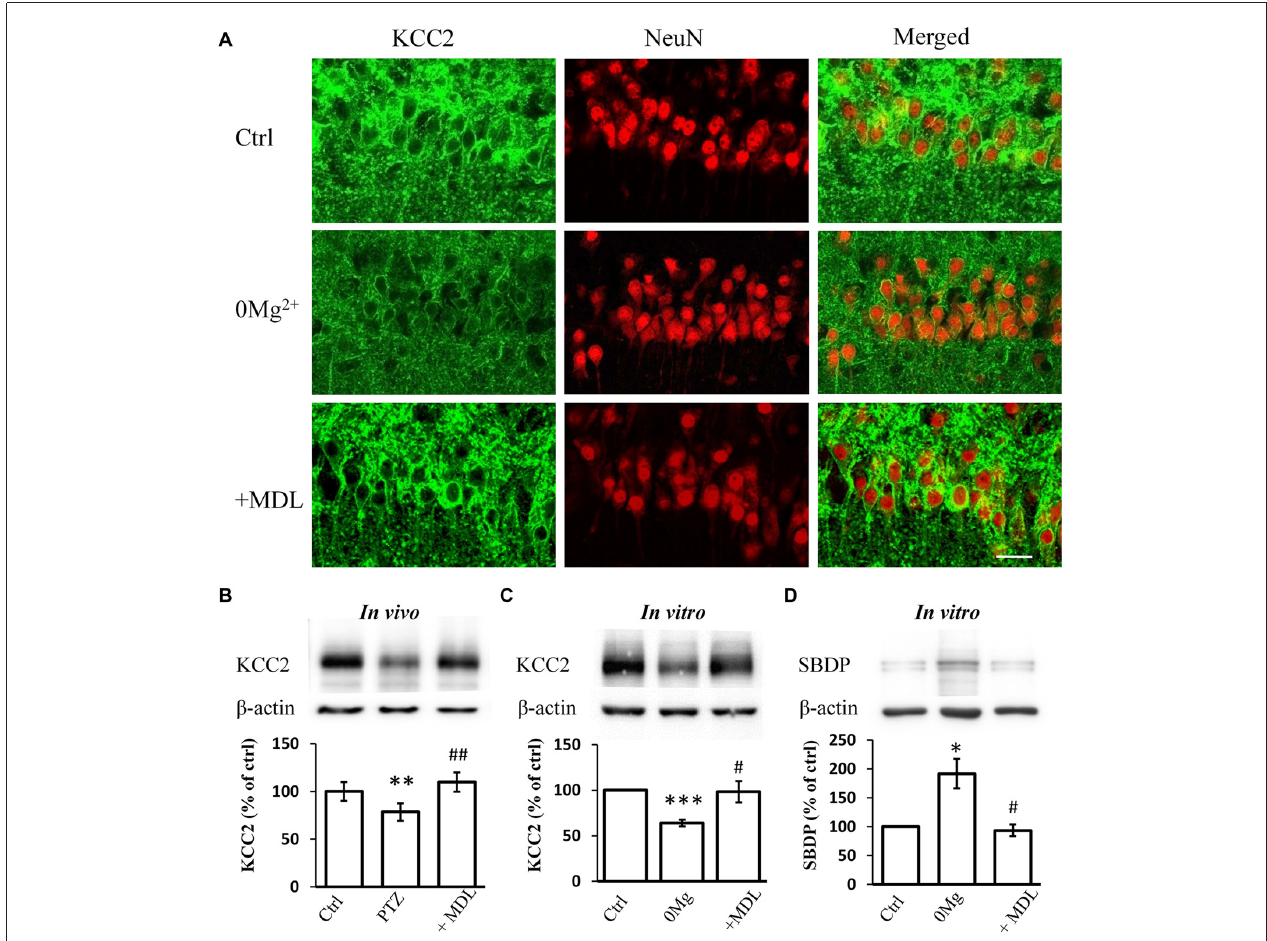
FIGURE 2 | MDL-28170 reverses the down regulation of potassium chloride co-transporter 2 (KCC2) during seizure induction. (A) KCC2 immunostaining showing expression of KCC2 in membrane of hippocampal CA1 neurons after 0 Mg 2 + (middle) or 0 Mg 2 + + MDL-28170 (bottom) treatment, in comparison with vehicle control (left). Green and red signals represent the KCC2 and NeuN immunostaining, respectively. Scale bar: 20 µ m. (B) The plasma membrane KCC2 (mKCC2) expression in hippocampus from PTZ alone or PTZ + MDL-21870 treated rats. The relative protein levels were normalized to the average of control group. (C) Spectrin breakdown product (mKCC2) expression from hippocampal slices. Slices were prepared from fresh brain and randomly divided into three different groups. KCC2 levels were normalized to control slices from the same preparation. (D) Spectrin breakdown product (SBDP)-145 level of 0 Mg 2 + and 0 Mg 2 + + MDL-28170 treated slices (total protein sample), normalized to control slices from the same preparation. ∗ p < 0.05 compared with vehicle-PTZ group; ∗∗ p < 0.01 compared with vehicle-PTZ group; ∗∗∗ p < 0.001 compared with vehicle-PTZ group; # p < 0.05 compared with 0 Mg 2 + group; ## p < 0.01 compared with 0 Mg 2 +